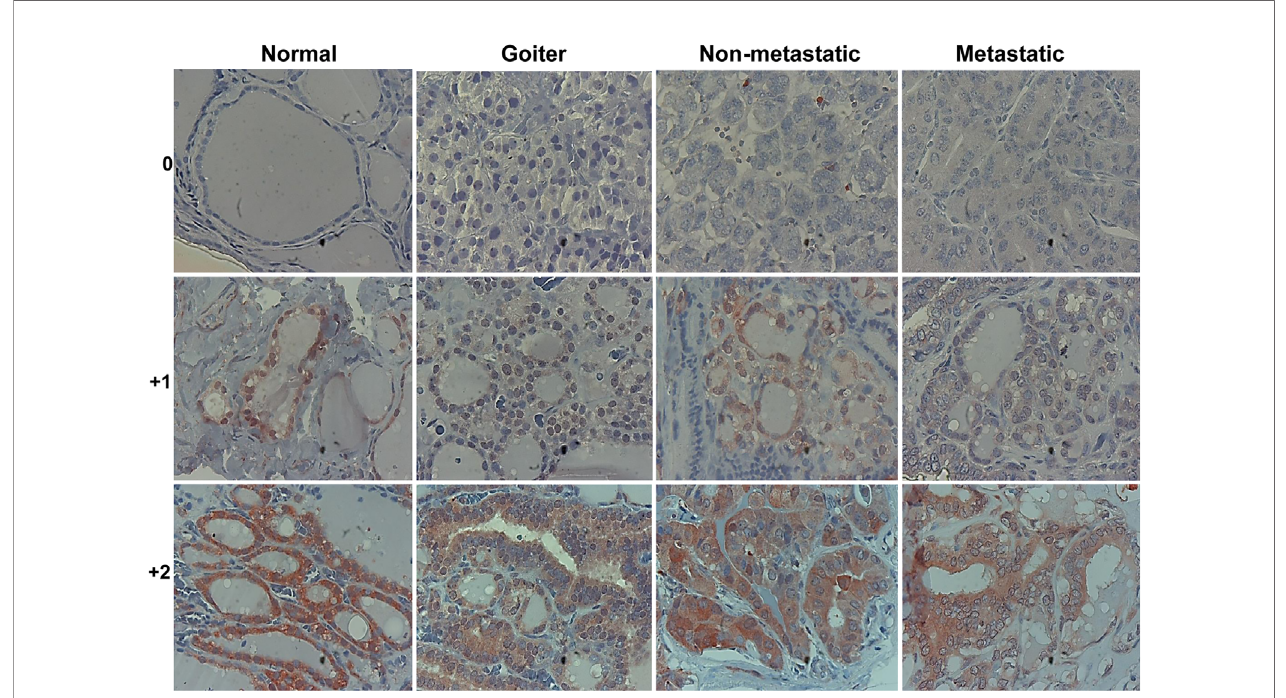
FIGURE 1 | Immunostaining. Five-micron sections of normal thyroid gland adjacent to thyroid carcinoma (left panels), benign (Goiter; second left), non-metastatic (second right), and metastatic thyroid carcinoma (right panels) were subjected to immunostaining applying anti-Hpa2 antibody (#58). Shown are representative photomicrographs of Hpa2-negative (upper panels) and positive biopsies exhibiting weak (+1; middle panels) or strong (+2; lower panels) staining intensity. Original magni fi cations